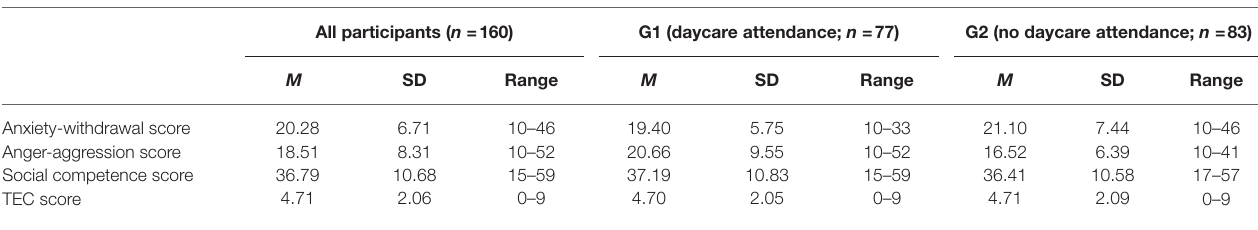
TABLE 2 | Descriptive data for social-emotional and behavioral measures.